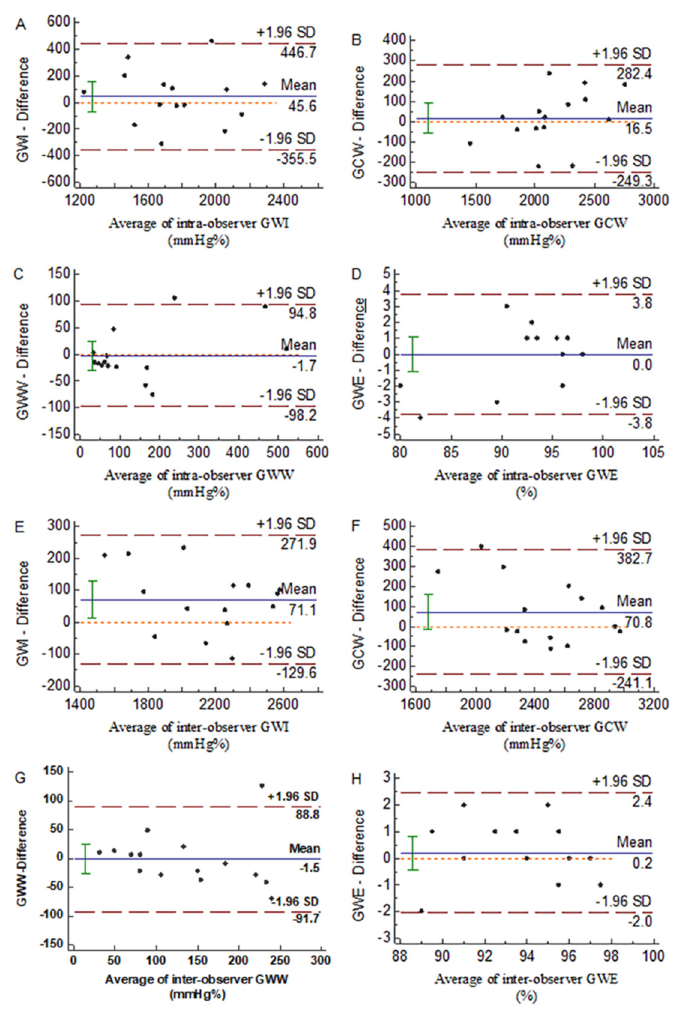
Figure 4. Bland − Altman plots of intra-observer agreement for: ( A ) GWI, ( B ) GCW, ( C ) GWW, and ( D ) GWE; Bland − Altman plots of inter-observer agreement for: ( E ) GWI, ( F ) GCW, ( G ) GWW, and ( H ) GWE. GWI, global work index; GCW, global constructive work; GWW, global waste work; GWE, global work efficiency.